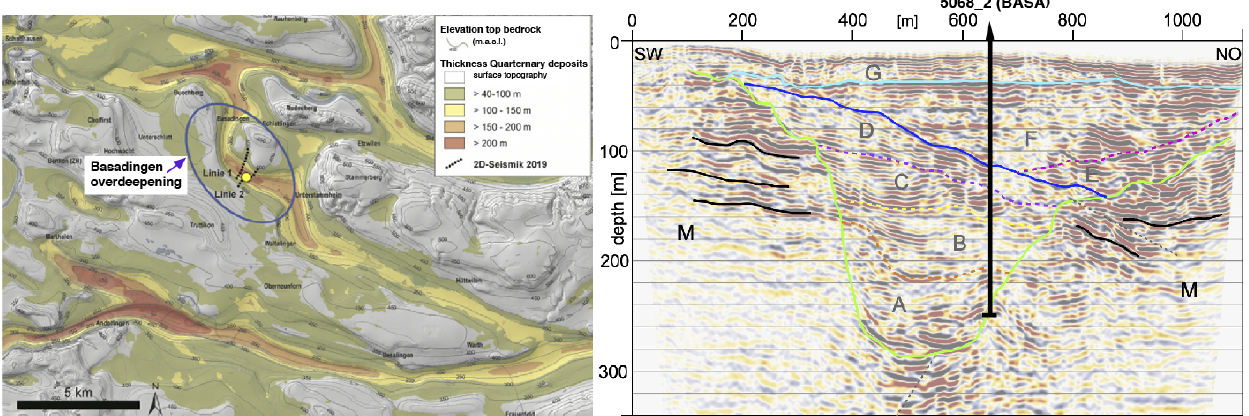
Figure 9. Left: location of primary DOVE Phase 1 site 5068_2 (BASA; yellow dot) in the overdeepened trough with a sediment thickness of up to 300m (bedrock model by Pietsch and Jordan, 2014). The parallel and partly crosscutting overdeepenings likely represent glacial erosional pulses of different ages. They all belong to the western lobe of the Rhine Glacier. Right: seismic Line 2 crossing the Basadingen trough (Brandt, 2020). Note the complex Quaternary sequences (A–G) composing the trough-filling stratigraphy. Bedrock (M) is at ∼ 255m